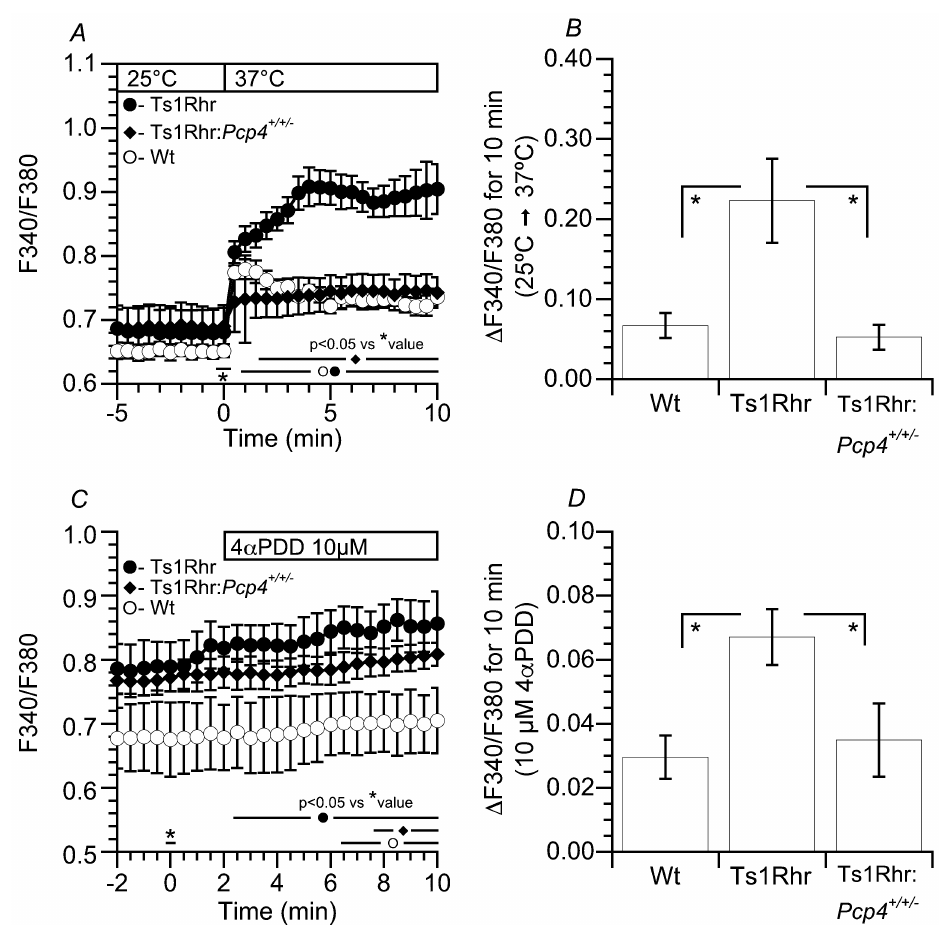
Figure 7. Changes in the [Ca 2 + ] i in airway ciliary cells stimulated by temperature and 4 α PDD in Wt, Ts1Rhr, and Ts1Rhr: Pcp4 +/+/ - . ( A, B ) Temperature. ( A ) Increasing the temperature from 25 ◦ C